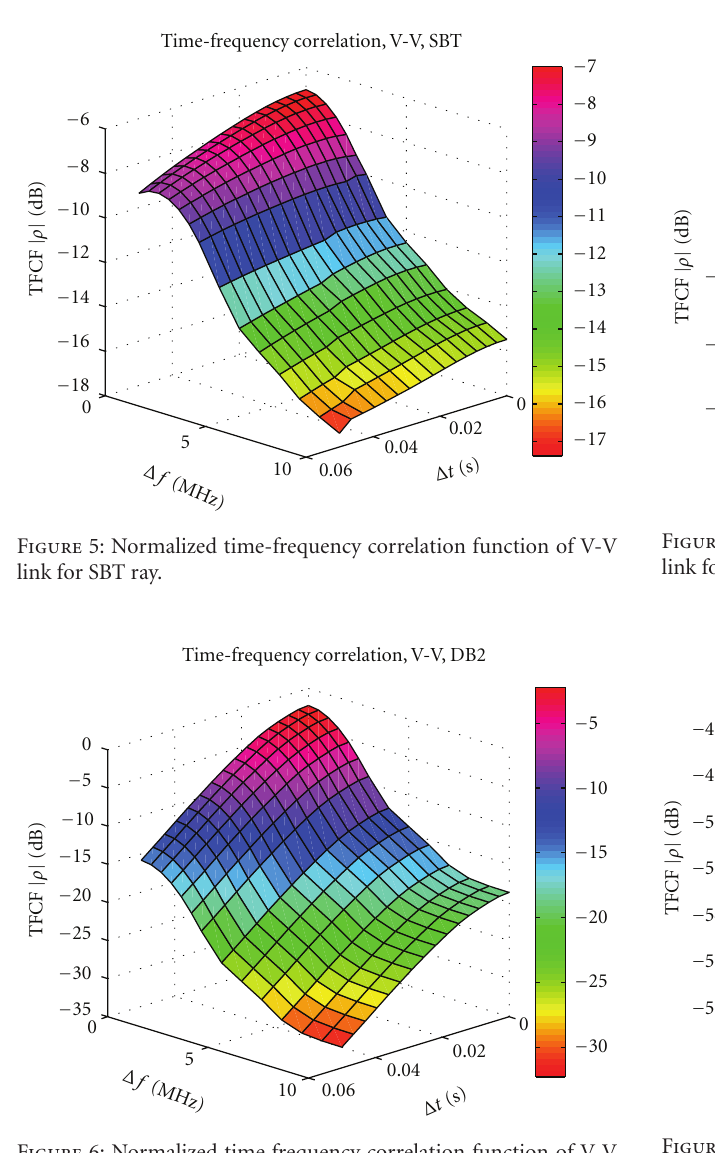
Figure 6: Normalized time frequency correlation function of V-V link for DB ray.